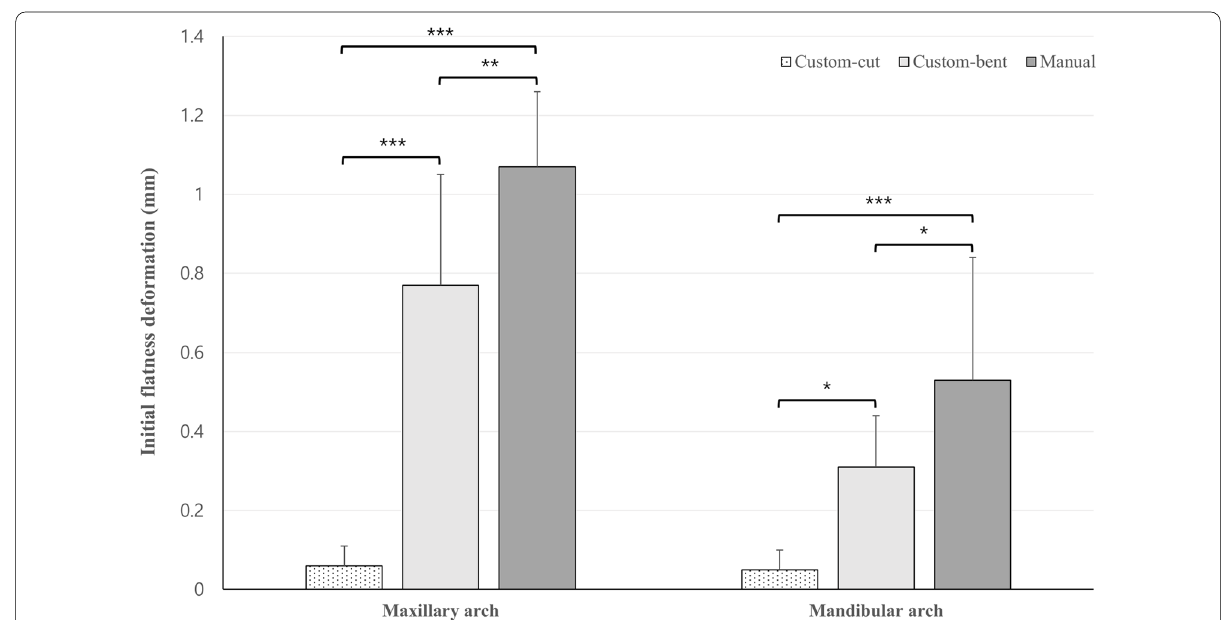
Fig. 9 Comparison of initial flatness deformation between three groups in maxillary and mandibular arch. * significance at the 0.05 level. ** significance at the 0.01 level. *** significance at the 0.001